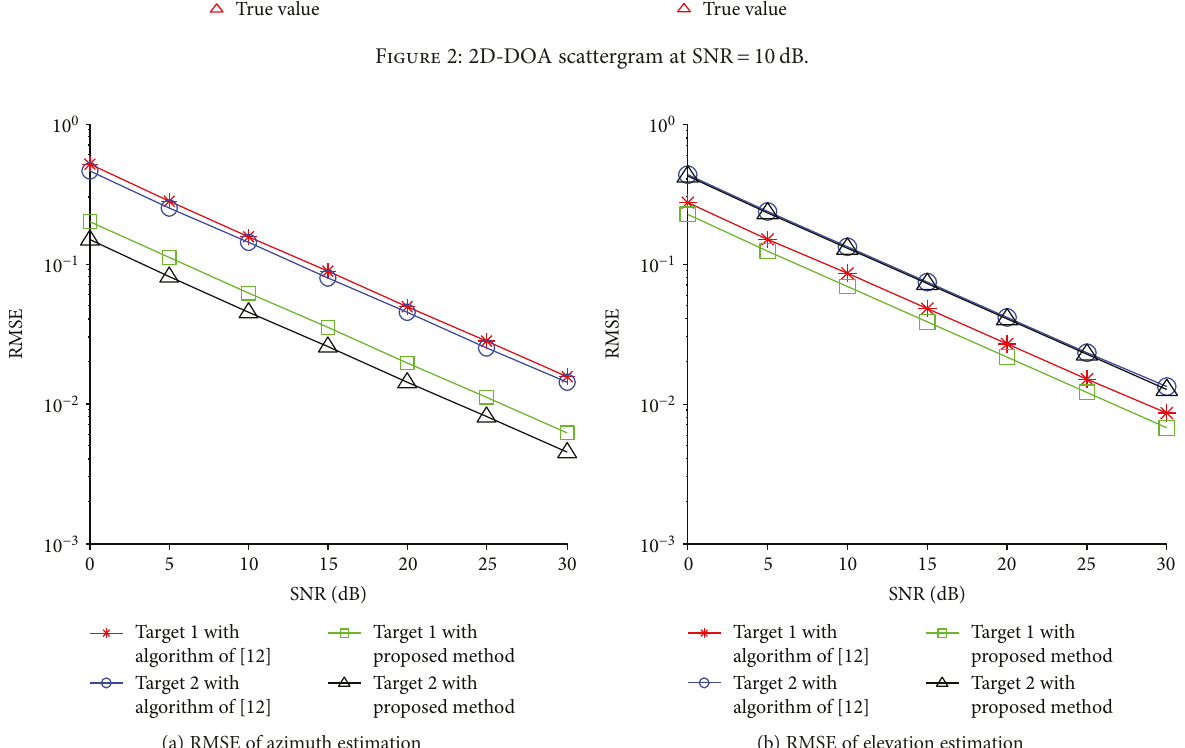
Figure 3: RMSE contrast of two algorithms with di ff erent